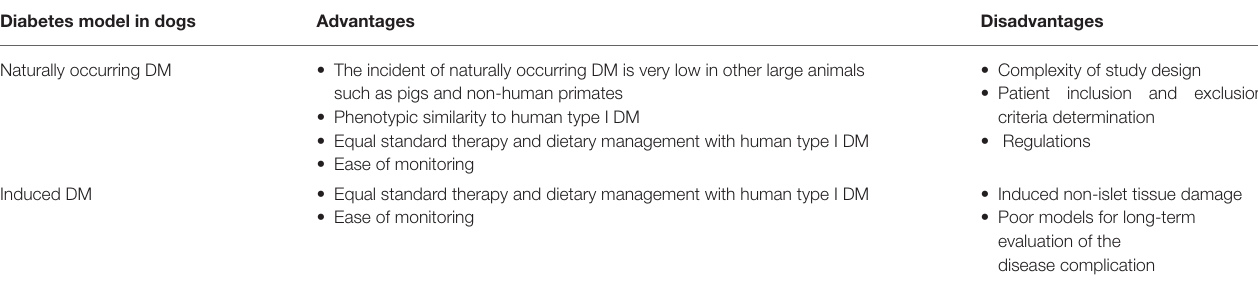
TABLE 1 | The advantages and disadvantages of the diabetes model in dogs. Diabetes model in dogs